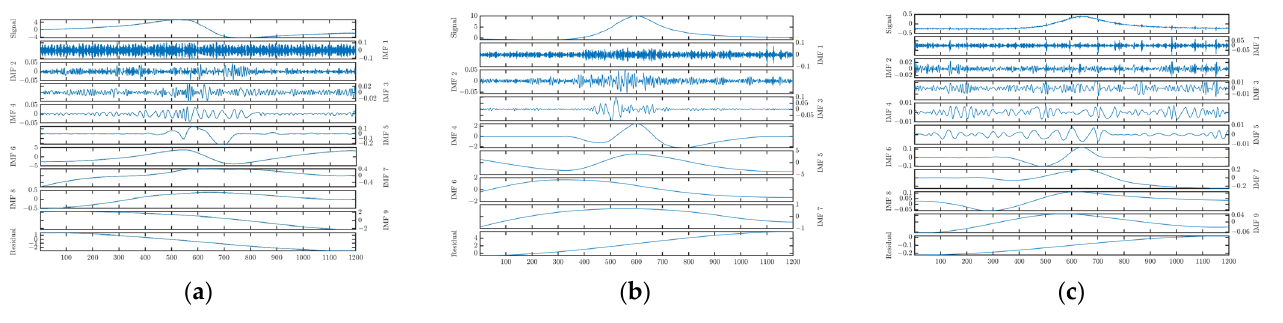
Figure 6. EMD decomposition diagram of enhanced magnetic memory testing signal. ( a ) EMD decomposition diagram of the normal component. ( b ) EMD decomposition diagram of the tangential component. ( c ) EMD decomposition diagram of the horizontal component.